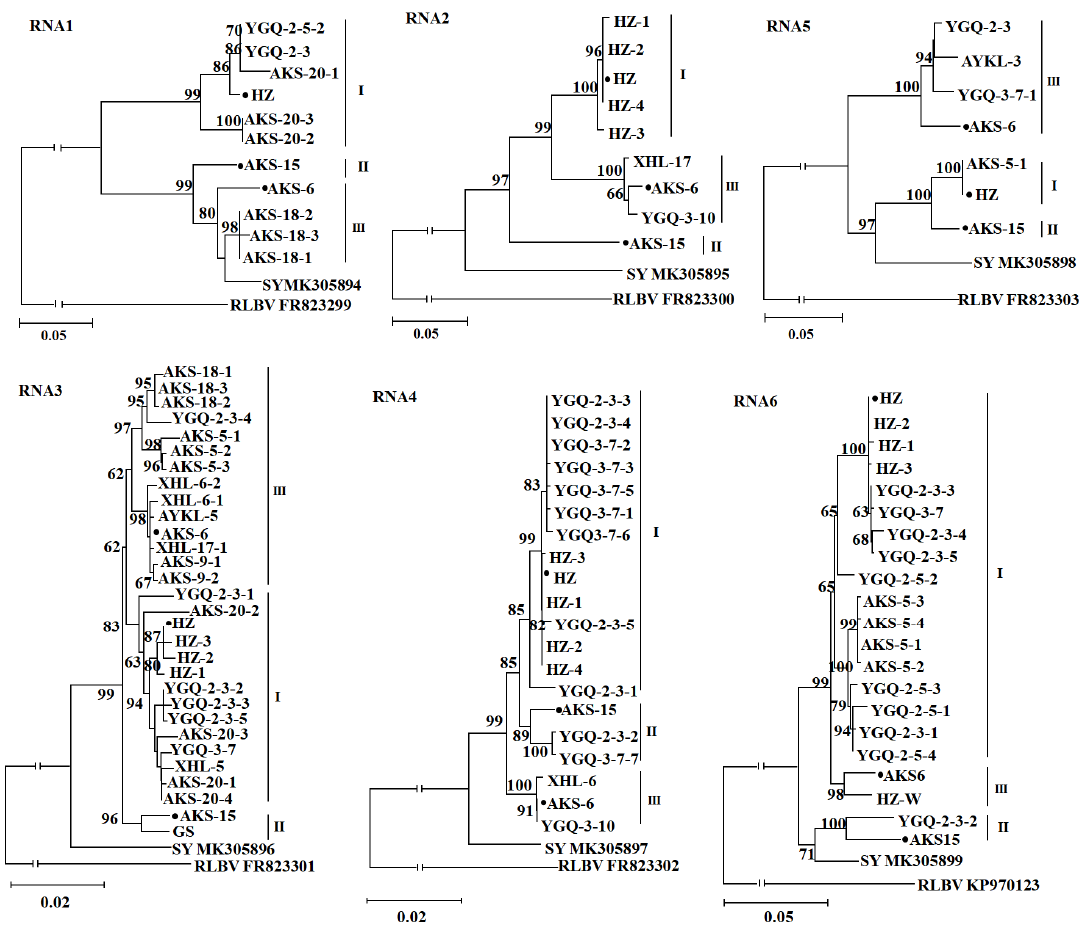
Figure 4. Unrooted neighbor joining (NJ) phylogenetic trees generated from the nucleotide sequences of RNAs 1–6 of jujube yellow mottle-associated virus (JYMaV). In the RNA1-based tree, fragments (525–1619 nt at 3 (cid:48) end of RNA1) obtained from samples AKS18, AKS20, YGQ-2-3 and YGQ-2-5 by RT-PCR using primer set 5H/3C were included in the assay. The sequence of reported isolate SY in each tree was marked by its isolate name followed by a GenBank accession number. Three JYMaV isolates determined by high throughput sequencing were highlighted by black dots. The corresponding RNA sequence of raspberry leaf blotch virus (RLBV) was used as an outgroup in each phylogenetic